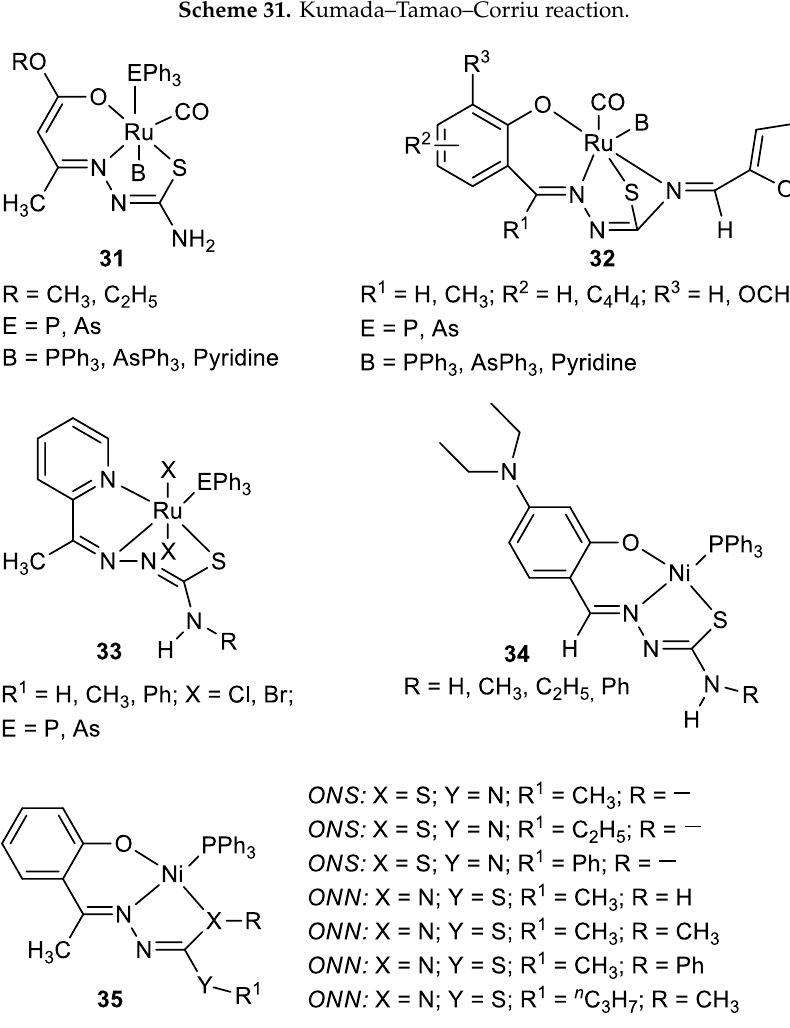
Figure 6. Representative metal complexes of thiosemicarbazones as catalysts for the Kumada – Tamao – Corriu reaction.